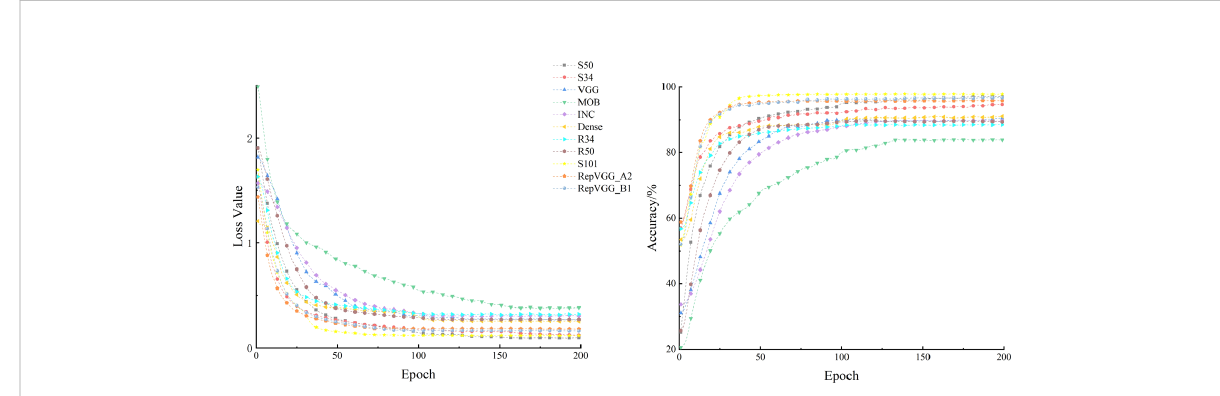
FIGURE 11 Variation of loss values and accuracy of different models on the validation set(Smoothing